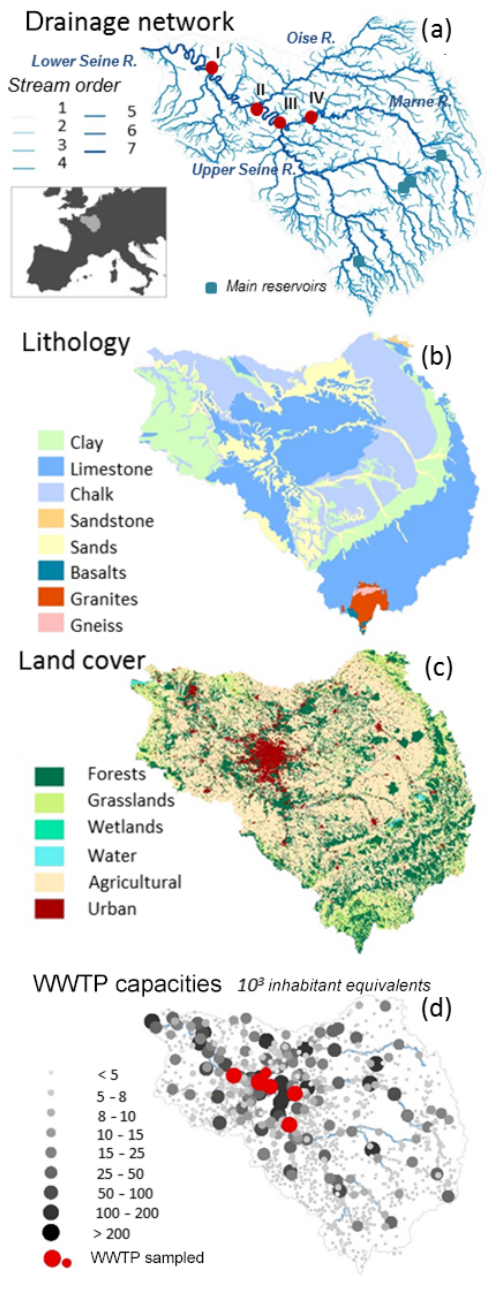
Figure 1. Characteristics of the Seine basin: (a) drainage network according to Strahler stream orders (Strahler, 1952, 1957) and mon- itoring stations (I: Poses, II: Poissy (downstream of Paris), III: Paris, IV: Ferté-sous-Jouarre (upstream from Paris)); (b) the lithology ac- cording to Albinet (1967); (c) land use according to the Corine Land Cover database, with six simplified classes (EEA, 2012); (d) wastewater treatment plants (WWTPs) of the basin. Red dots are the WWTPs sampled in